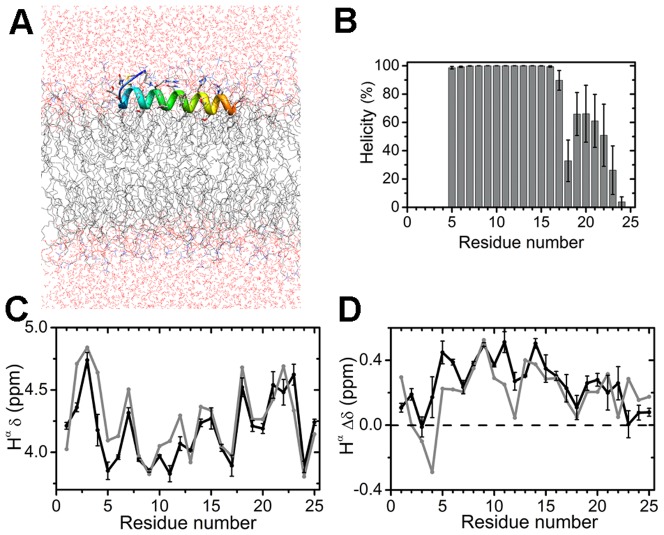
Simulations of membrane-bound wild-type hIAPP1–25 (+3).(A) Initial position and orientation of the peptide in the membrane. All of the biomolecular images in this work were generated using the Chimera [71] package. The peptide is rendered as a ribbon with its N-terminus in blue and C-terminus in orange. The water and membrane molecules are shown by the wire model. The coloring scheme for the atoms of water and membrane are: red (O atom), blue (N atom), grey (C atom), orange (P atom) and white (H atom). The scheme is used in all of the following figures. (B) Helicity. (C) Hα chemical shifts. The black line denotes the simulation result and the grey line represents the experiment data [12]. (D) Simulated (black line) and experimental (gray line) Hα secondary shifts. The average values and the error bars in (B)–(D) were calculated over five trajectories.